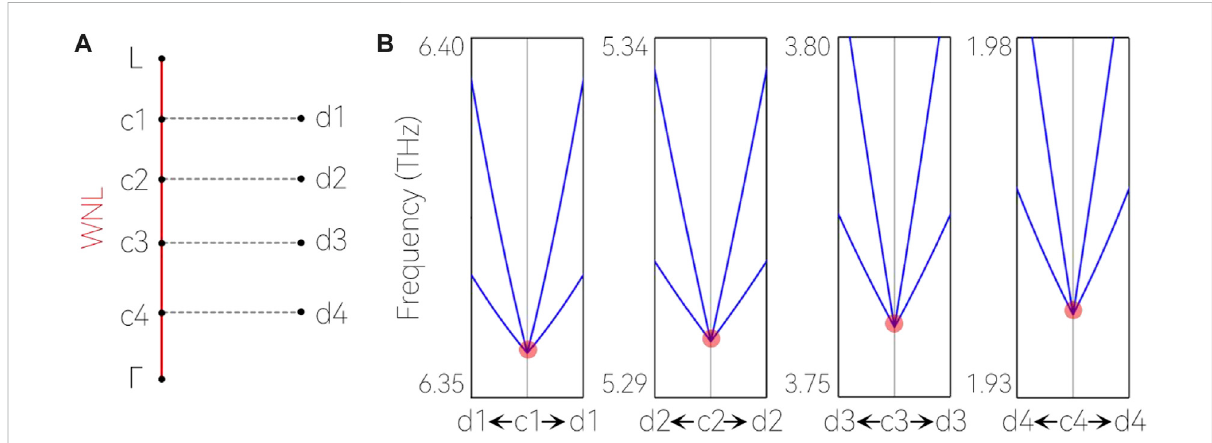
in Figure 6B. The band crossings (highlighted by red balls) with a linear band dispersion appear on the selected k paths, i.e., dn-cn-dn ( n = 1 –